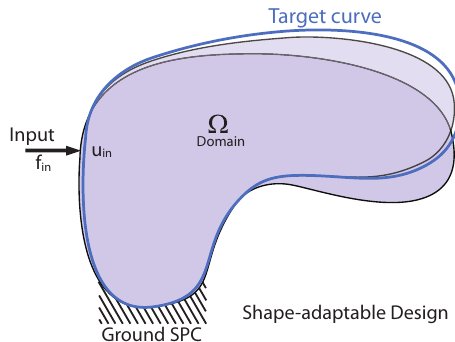
Figure 3. Shape-adaptable design: compliance for desired shape